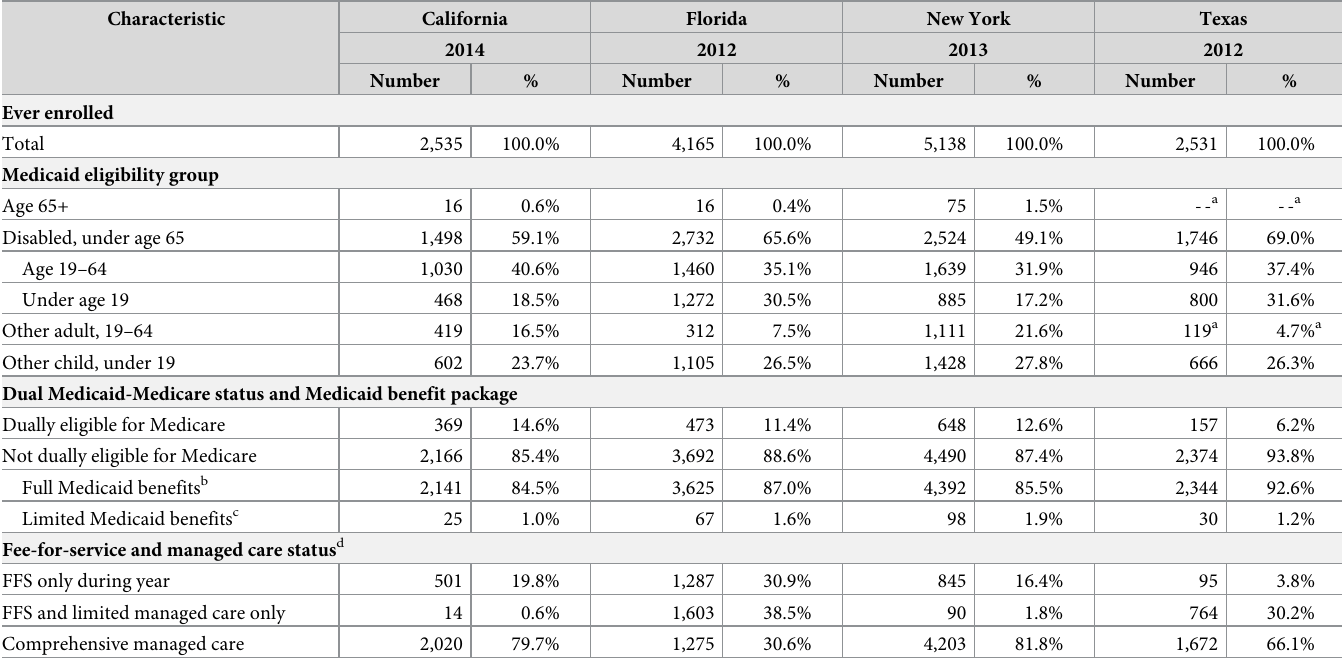
Table 1. Eligibility and benefit characteristics of Medicaid enrollees with SCD.